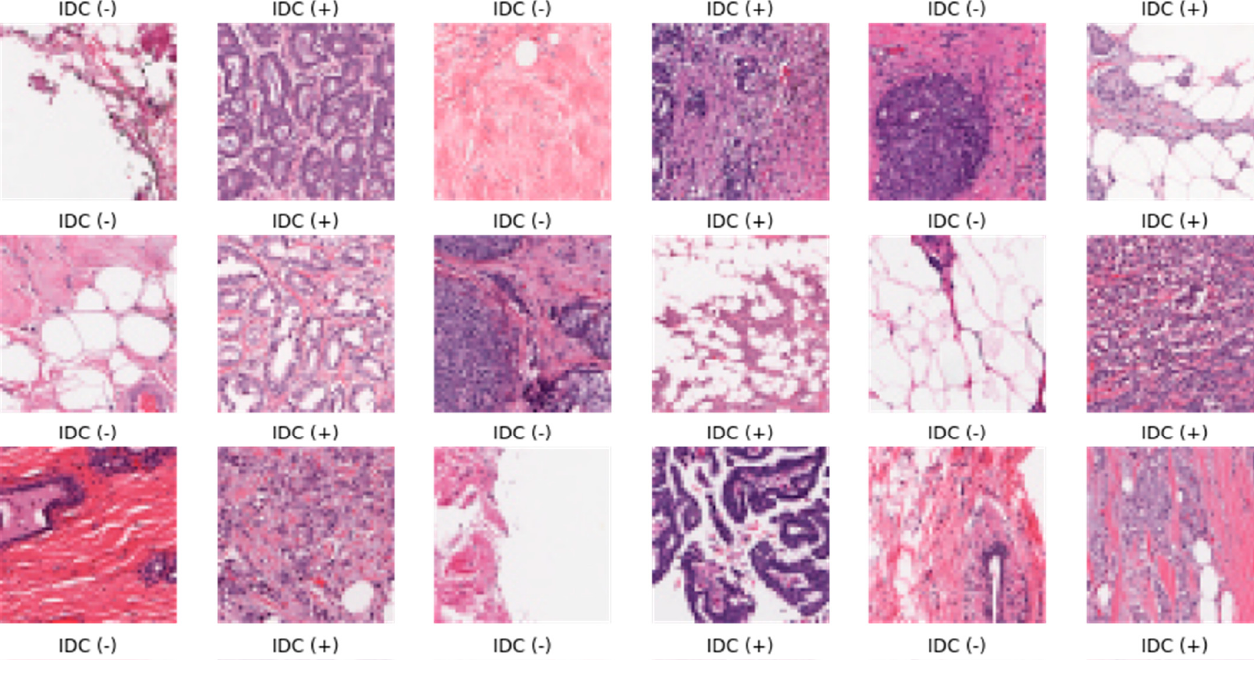
Figure 16. Images of classification results with basic 3D U-Net classifier.